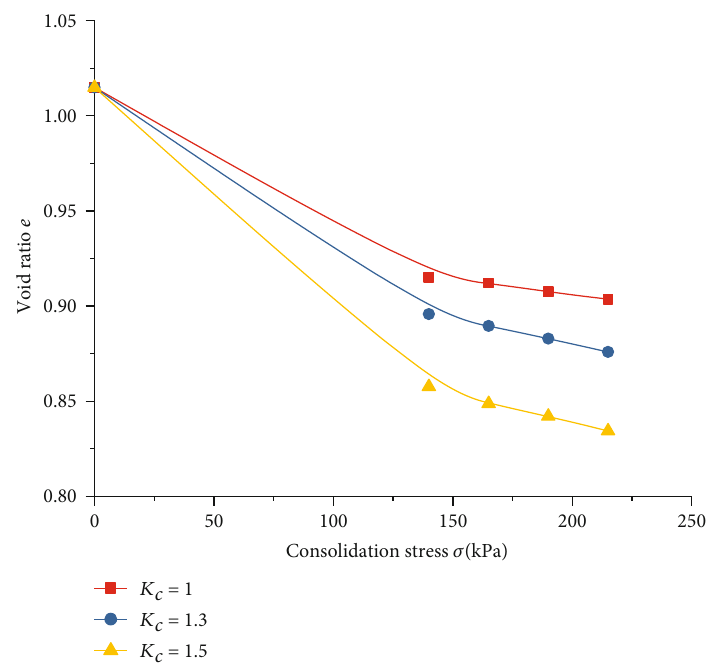
Figure 6: The curve of void ratio of normally consolidation clay with consolidation pressure at di ff erent consolidation stress